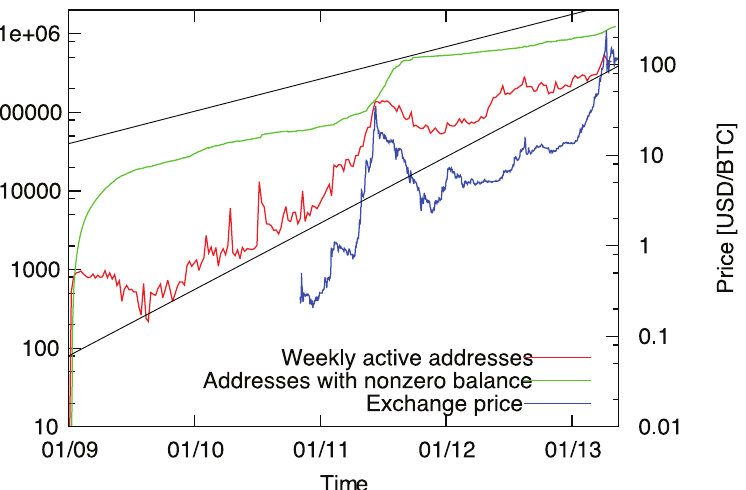
Figure 1. The growth of the Bitcoin network. Number of addresses with nonzero balance (green), addresses in participating in at least one transaction in one week intervals (red) and the exchange price of bitcoins in US dollars according to MtGox, the largest Bitcoin exchange site (blue). The black lines are exponential functions bounding the growth of the network size; the characteristic times are 188 and 386 days.